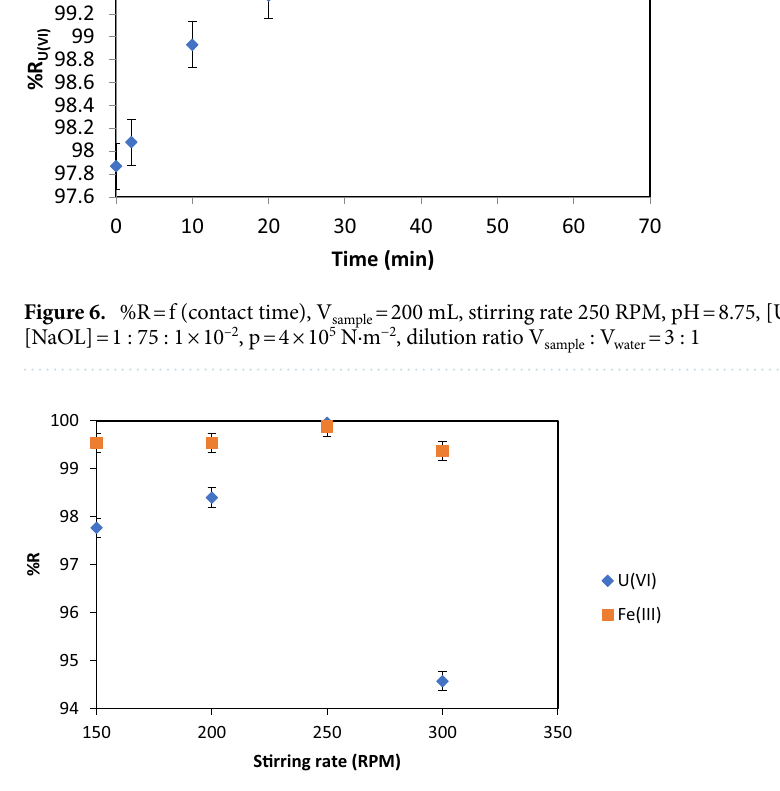
Figure 7. %R = f (stirring rate), V sample = 200 mL, contact time 30 min, pH = 8.75, molar ratio [U(VI)] : [Fe (III)] : [NaOL] = 1 : 75 : 1 × 10 –2 , p = 4 × 10 5 N·m −2 , dilution ratio V sample : V water = 3 : 1